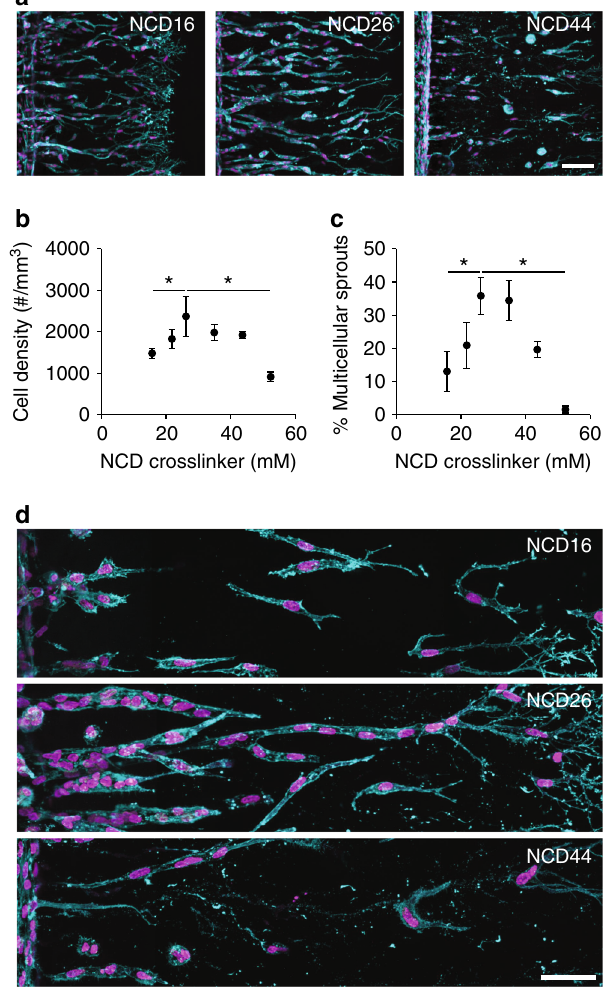
Fig. 4 Angiogenic sprout multicellularity is controlled by matrix crosslinking. a HUVECs invading into DexMA gels crosslinked with 16, 26, and 44 mM MMP-labile NCD peptides analyzed at a constant invasion depth after 1, 3.5, and 15 d, respectively. Composite fl uorescence images showing F-actin ( cyan ) and nuclei ( magenta ) ( scale bar , 100 μ m). b Quanti fi cation of HUVEC density as a function of NCD crosslinker concentration. c Sprout multicellularity (% of sprouts possessing six or more nuclei) as a function of NCD crosslinker concentration. d Morphology of sprouts invading into DexMA gels of different NCD crosslinker concentrations. Composite fl uorescence images showing F-actin ( cyan ) and nuclei ( magenta ) ( scale bar , 50 μ m). All data are presented as a mean ±